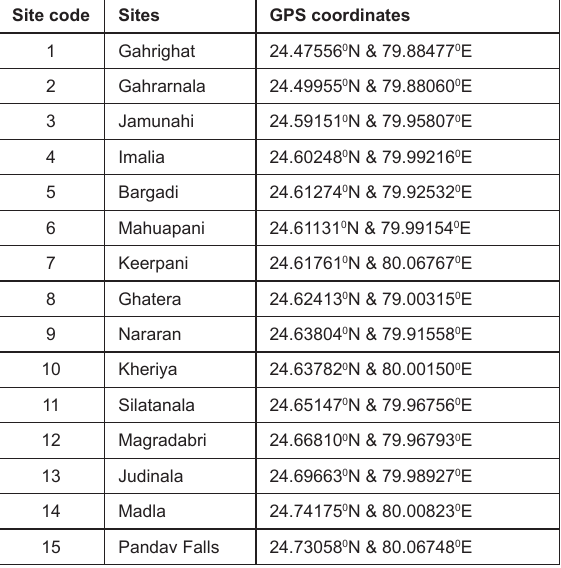
Table 1. Summary of study sites in Ken River basin of Panna landscape, Madhya Pradesh. Site